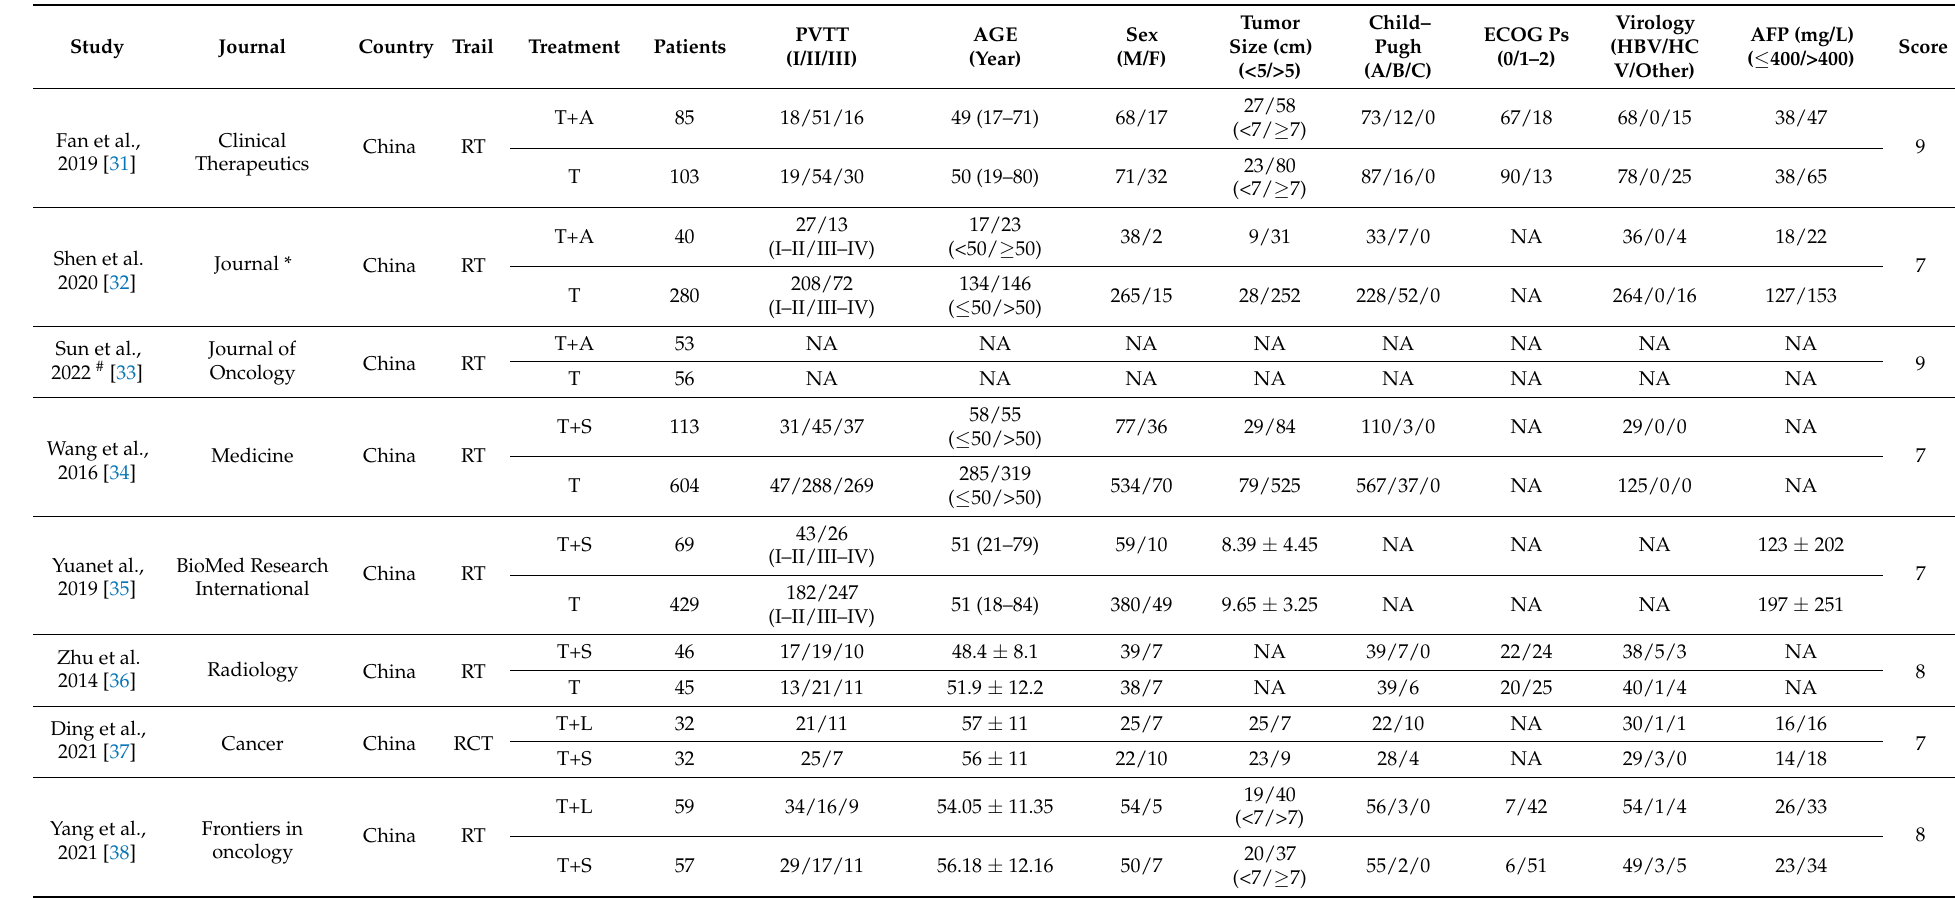
Table 1. Baseline characteristics of the